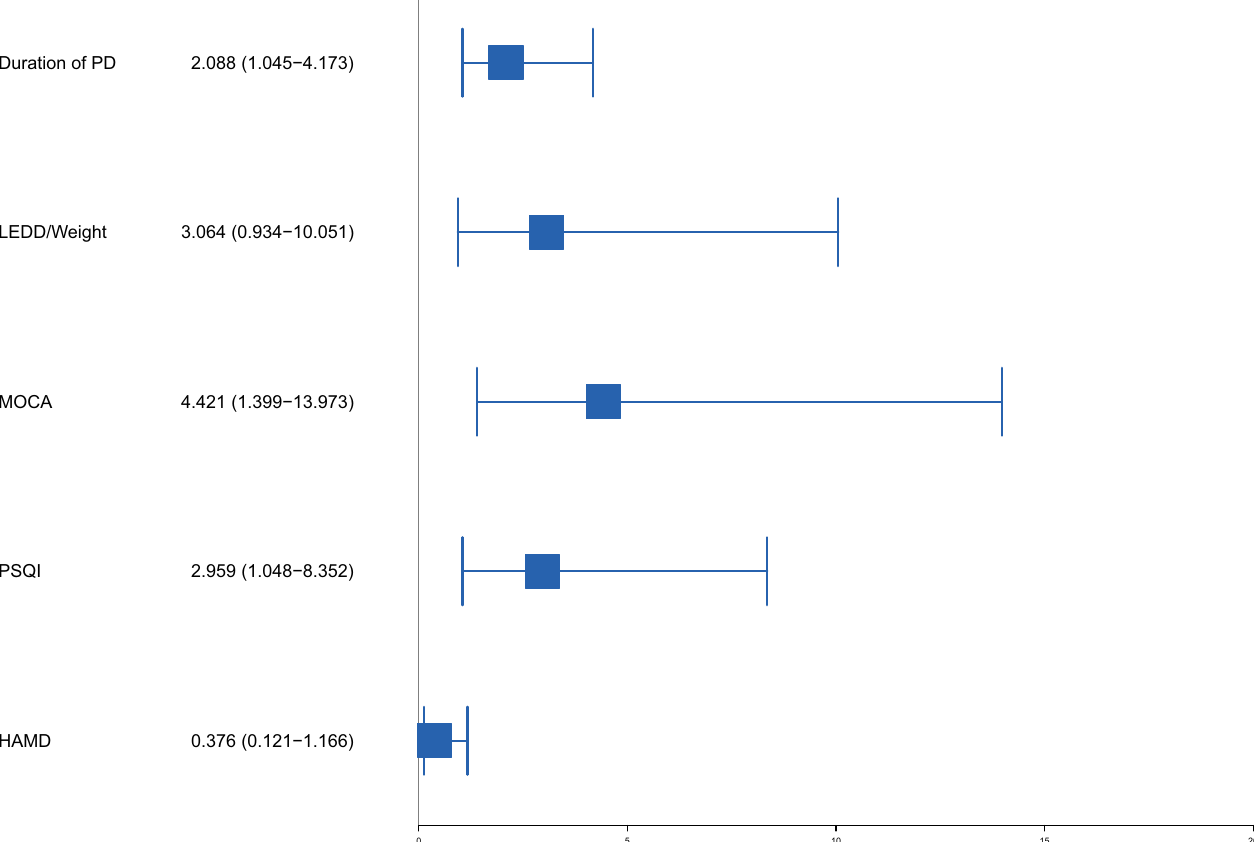
Fig. 4 Forest plot of multivariable Cox regression analysis. LEDD Levodopa equivalent daily dose, MOCA Montreal Cognitive Assessment, PSQI Pittsburgh Sleep Quality Index, HAMD Hamilton Depression Rating Scale.